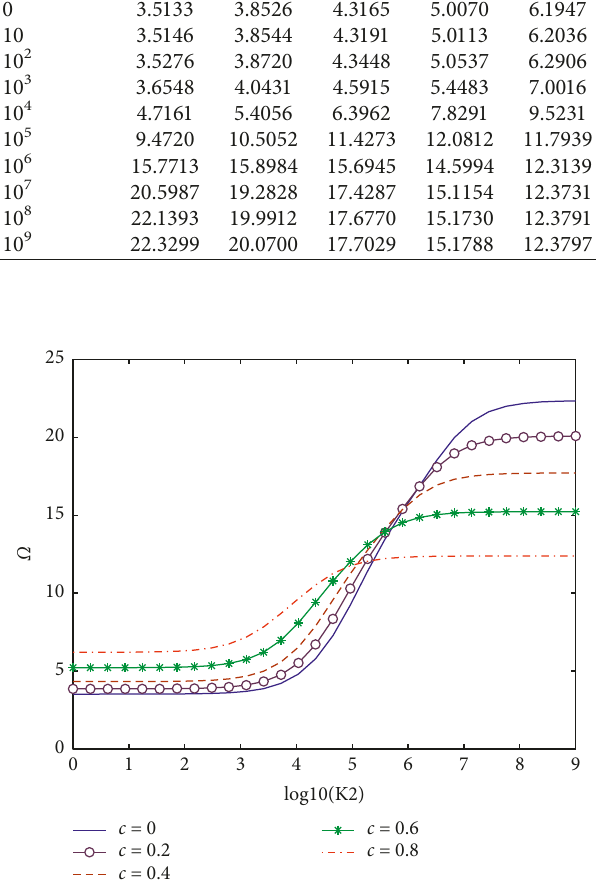
Figure 4: Nondimensional fundamental frequencies of the non- uniform double-beam system with r